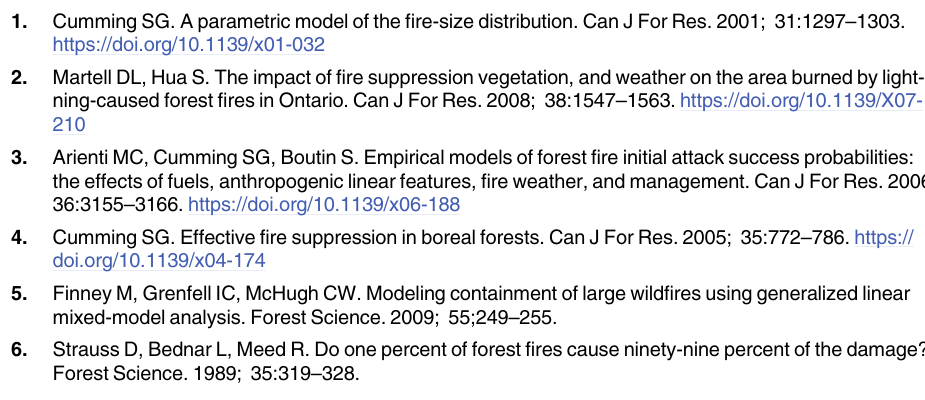
S8 Fig. Distribution of initial attack size among each method of intervention given that a fire has grown between IA and BH. S1 Table. List of variables available at the beginning of variable selection for classification (except interaction terms) procedure and survival